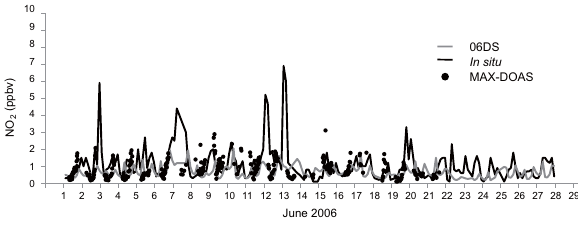
Fig. 7. Hourly NO 2 concentrations at the summit of Mount Tai (36 ◦ N, 117 ◦ E, 1533m a.s.l.). MAX-DOAS NO 2 is the mean NO 2 concentrations for the 1–2km layer above surface at